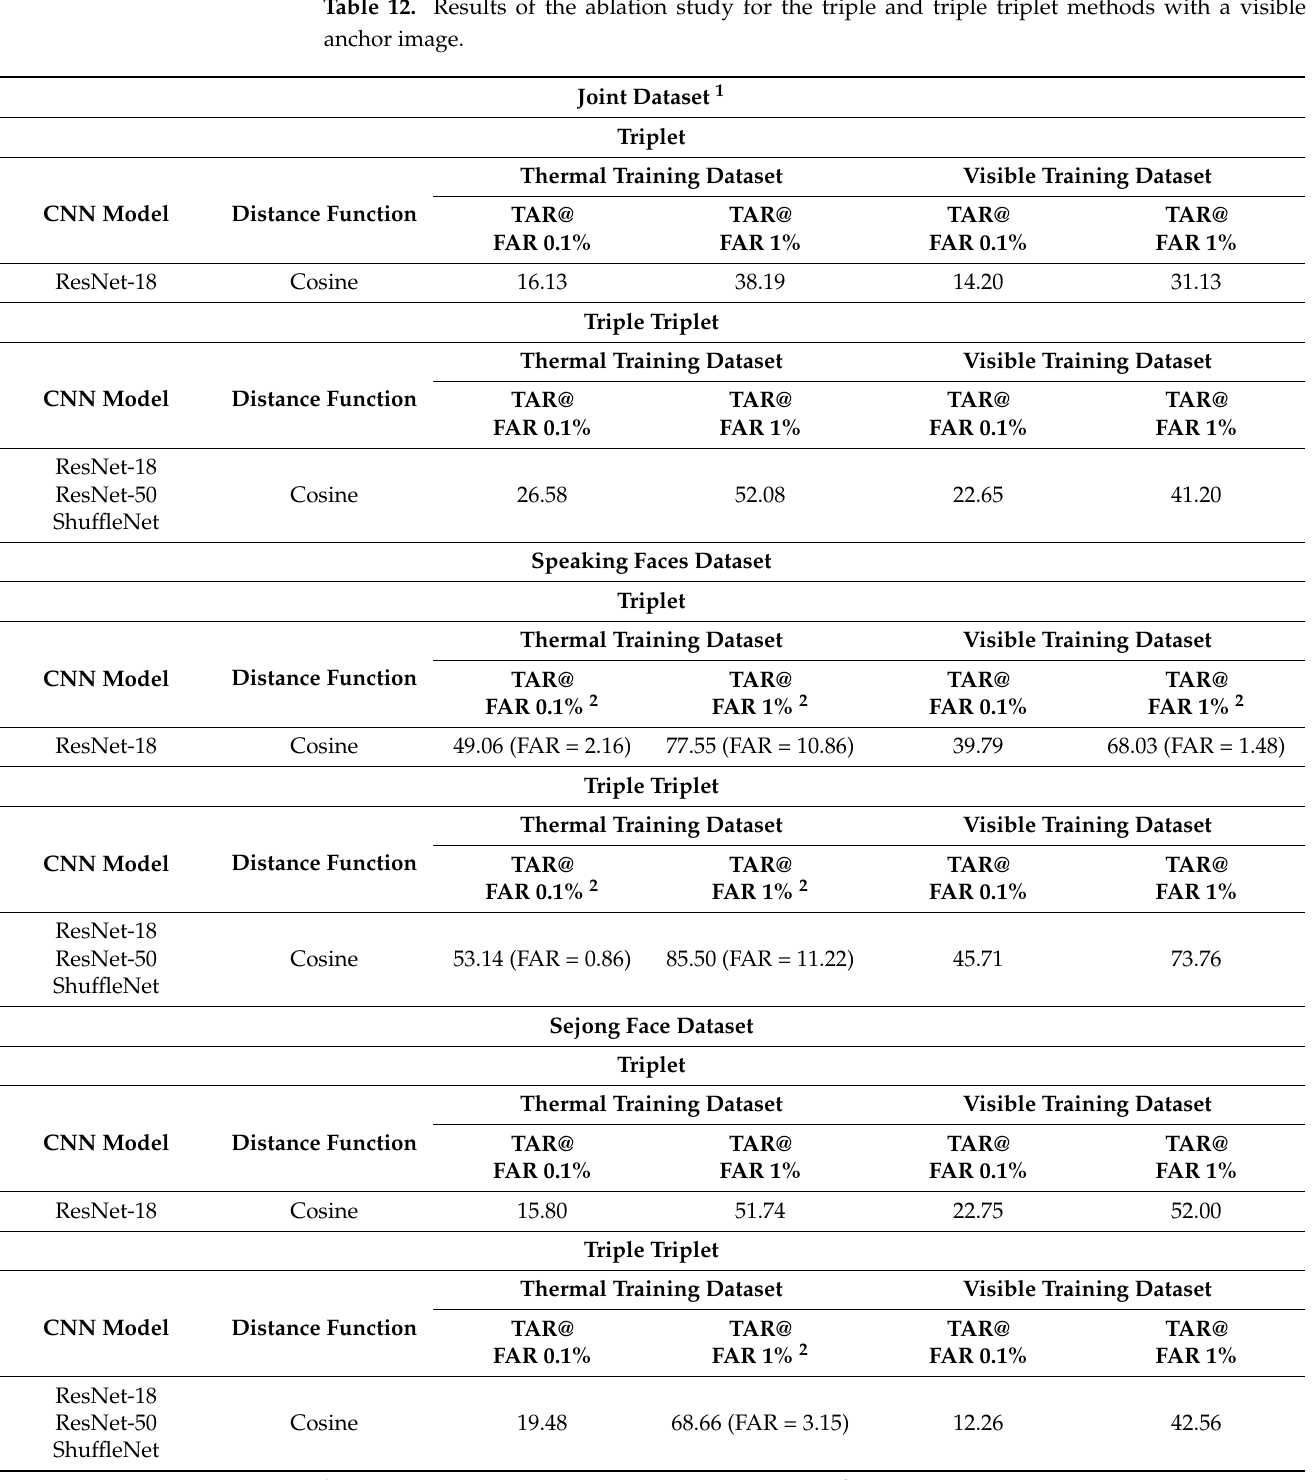
Table 12. Results of the ablation study for the triple and triple triplet methods with a visible anchor